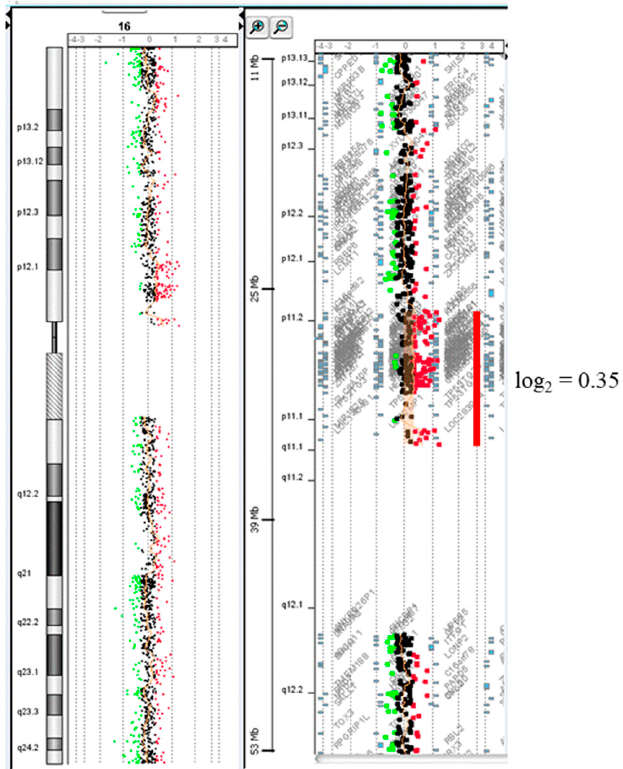
Figure 4. Chromosome microarray analysis using CytoScan gene chip (Agilent customer design ID 040427, Changhua Christian Hospital, Changhua, Taiwan) on blood cord demonstrated 55% mosaicism (inferred from the mean log 2 ratio of 0.35) of 16p12.1p11.1 duplication with 8.02 Mb in size (arr[GRCh37]16p12.1p11.1(27021975_35045499)×3[0.55]).